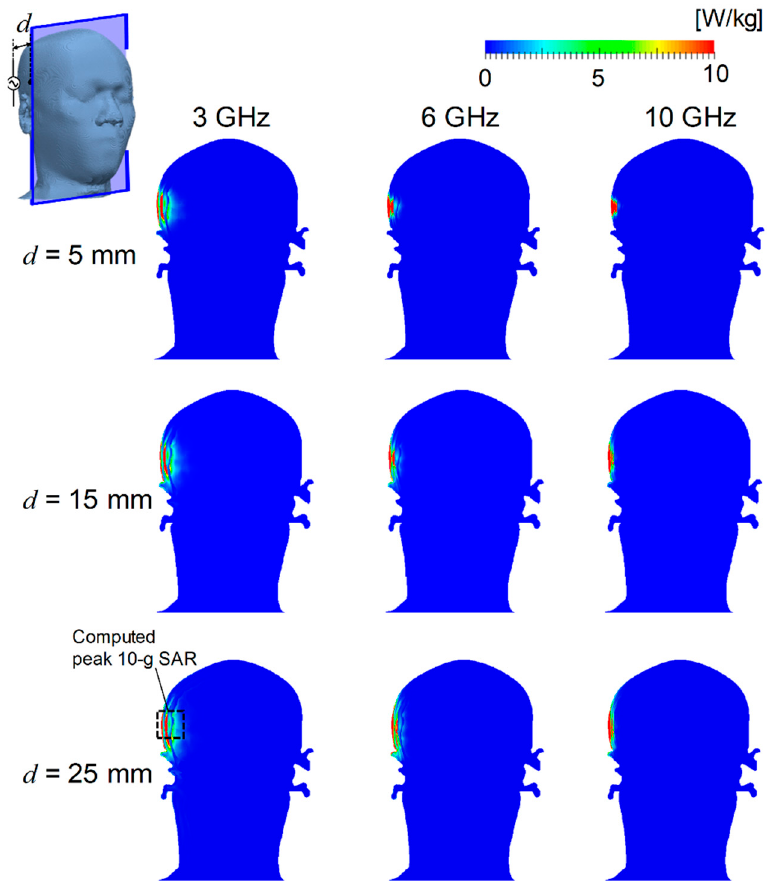
Figure 3. SAR distribution in the TARO model at 3, 6, and 10 GHz. The distances between the skin surface and the dipole antenna d were set to 5, 15, and 25 mm. The output power of the antenna was adjusted so that the peak SAR averaged over 10-g tissue was equal to 10 W/kg. The dashed square shows the region with a computed peak of 10-g SAR.